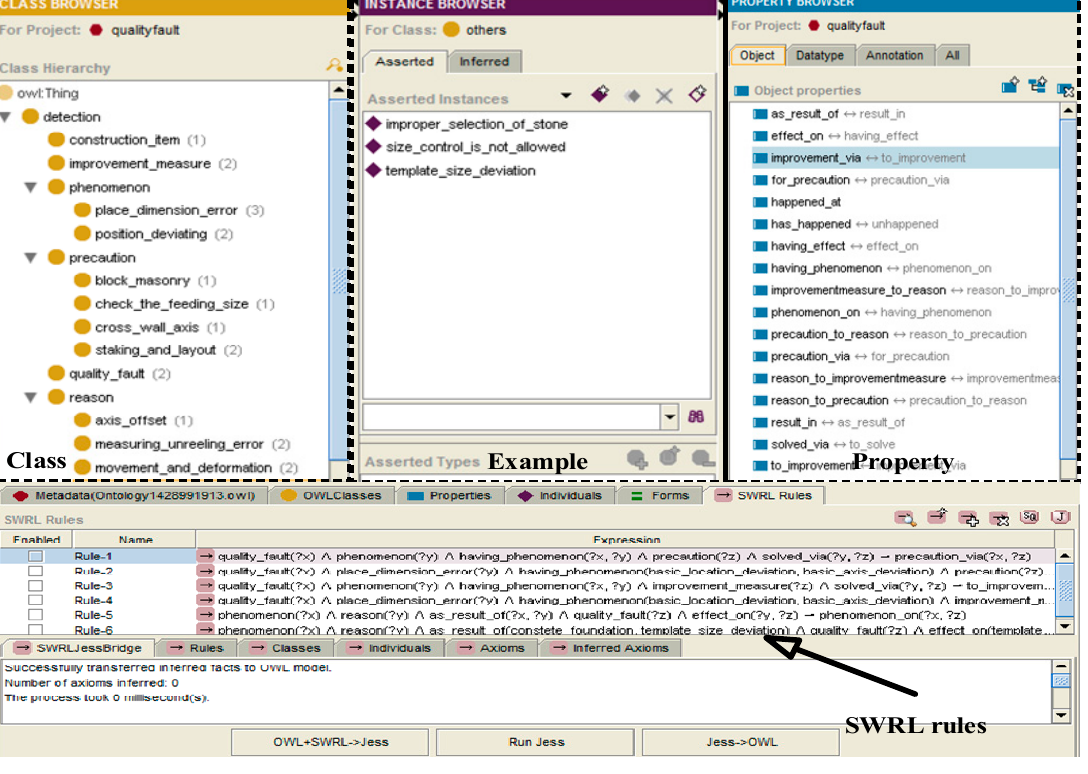
Figure 14. Some classes and instances built by Protégé.